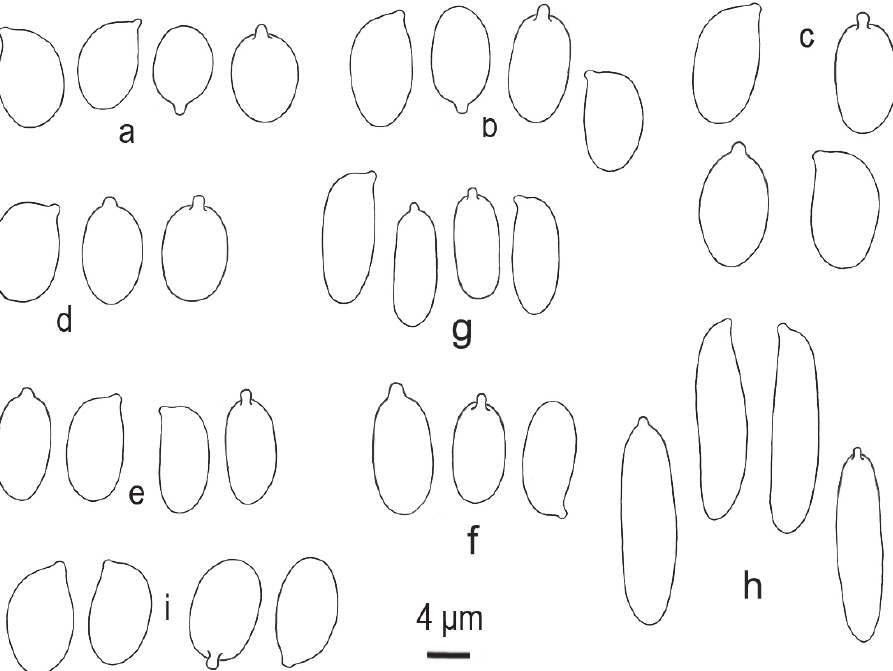
Figure 3. Basidiospores of Clavariadelphus under light microscope. a C. alpinus (HKAS 57396, holo- type) b C. amplus (HKAS 54876, holotype) c C. elongatus (HKAS 76589) d C. gansuensis (HKAS 76487, holotype) e C. himalayensis (HKAS 58811) f C. khinganensis (MHHNU 7789, holotype) g C. ligula (HKAS 35954) h C. sachalinensis (MHHNU 7816) i C . yunnanensis (HKAS